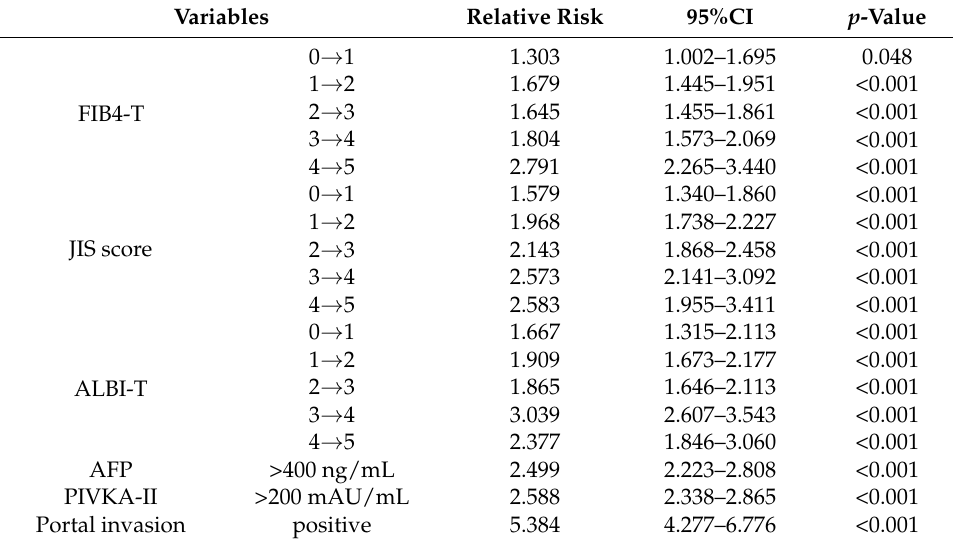
Table 5. Prognostic values defined by the Cox proportional hazard